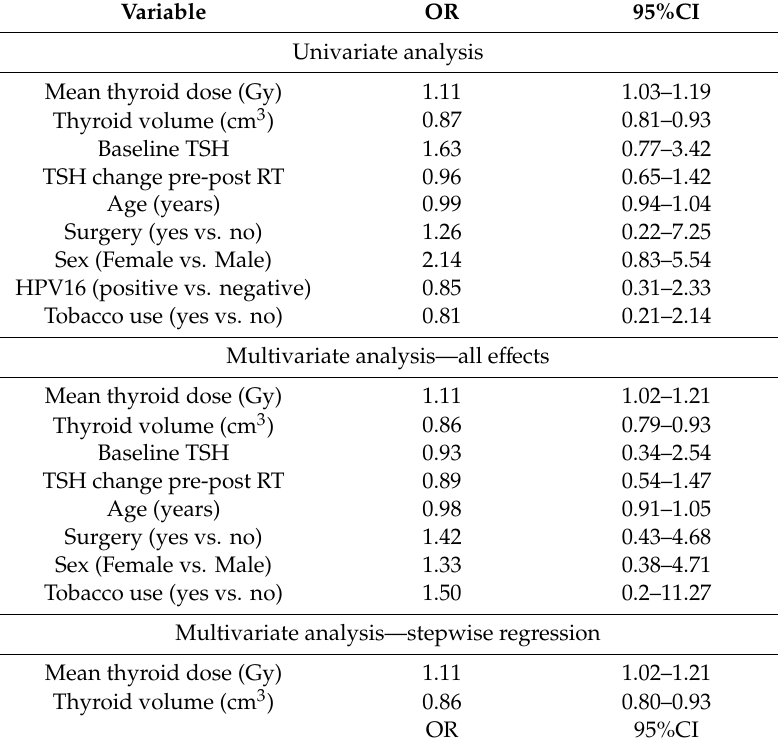
Table 3. Results of univariate and multivariate logistic regression analyzing the predictor association with